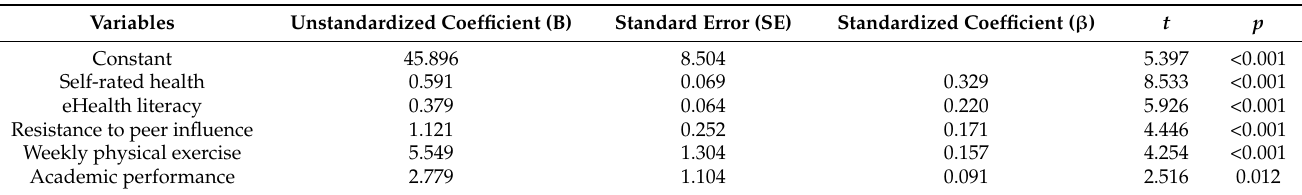
Table 3. Multivariate linear regression analysis of health self-management ability among Chinese healthcare undergraduates.